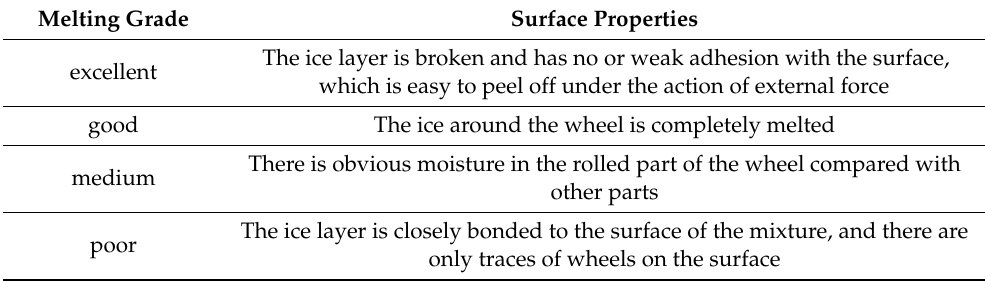
Table 7. Anti-freezing ability evaluation.